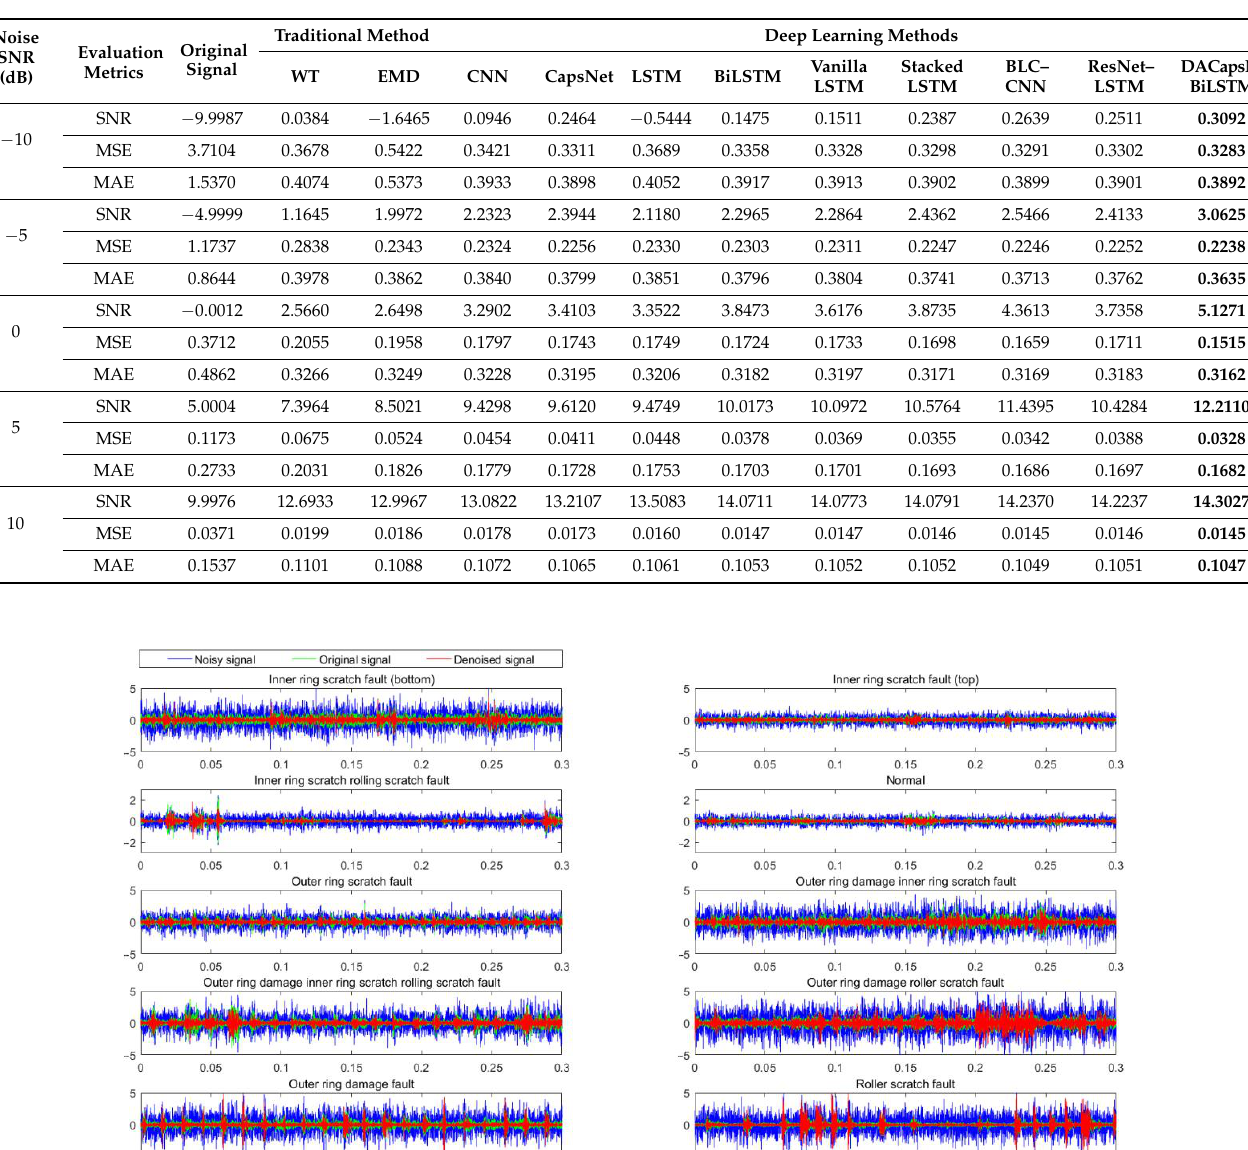
Table 5. Comparison of noise reduction performance at different noise levels.